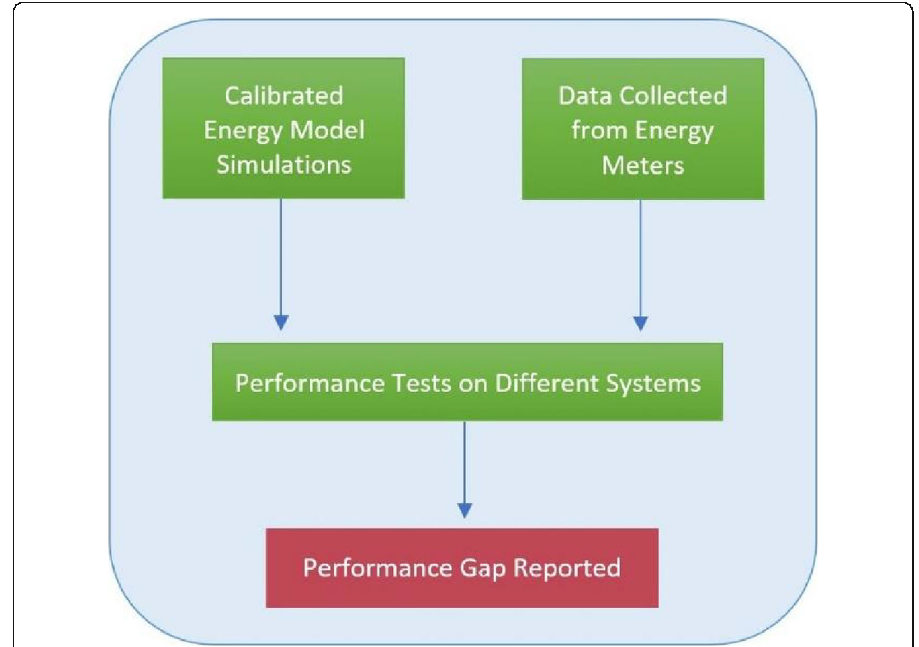
Fig. 5 Online energy performance monitoring and evaluation tool (ObepME) framework (Jradi et al.,